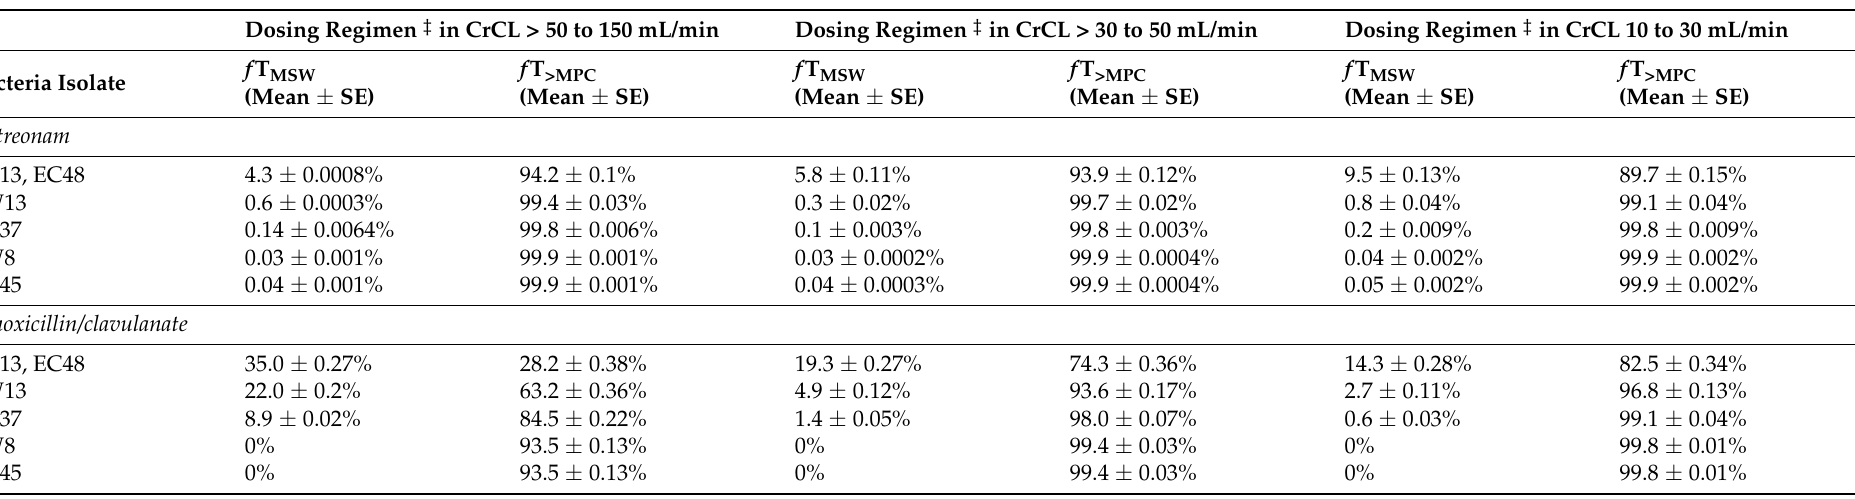
Table 5. Pharmacodynamic parameters f T MSW and f T >MPC computed based on MIC and MPC of aztreonam and amoxicillin/clavulanate as combination therapy in the epithelial lining fluid against E. coli and K. pneumoniae isolates harboring NDM and serine- β -lactamases. Dosing Regimen ‡ in CrCL > 50 to 150 mL/min Dosing Regimen ‡ in CrCL > 30 to 50 mL/min Dosing Regimen ‡ in CrCL 10 to 30